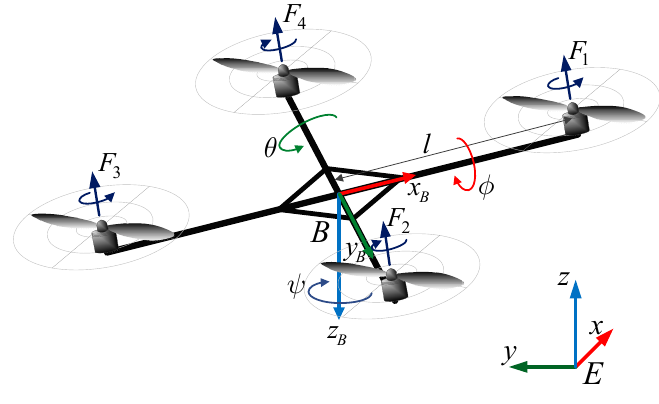
Figure 2. Quadcopter’s configuration.